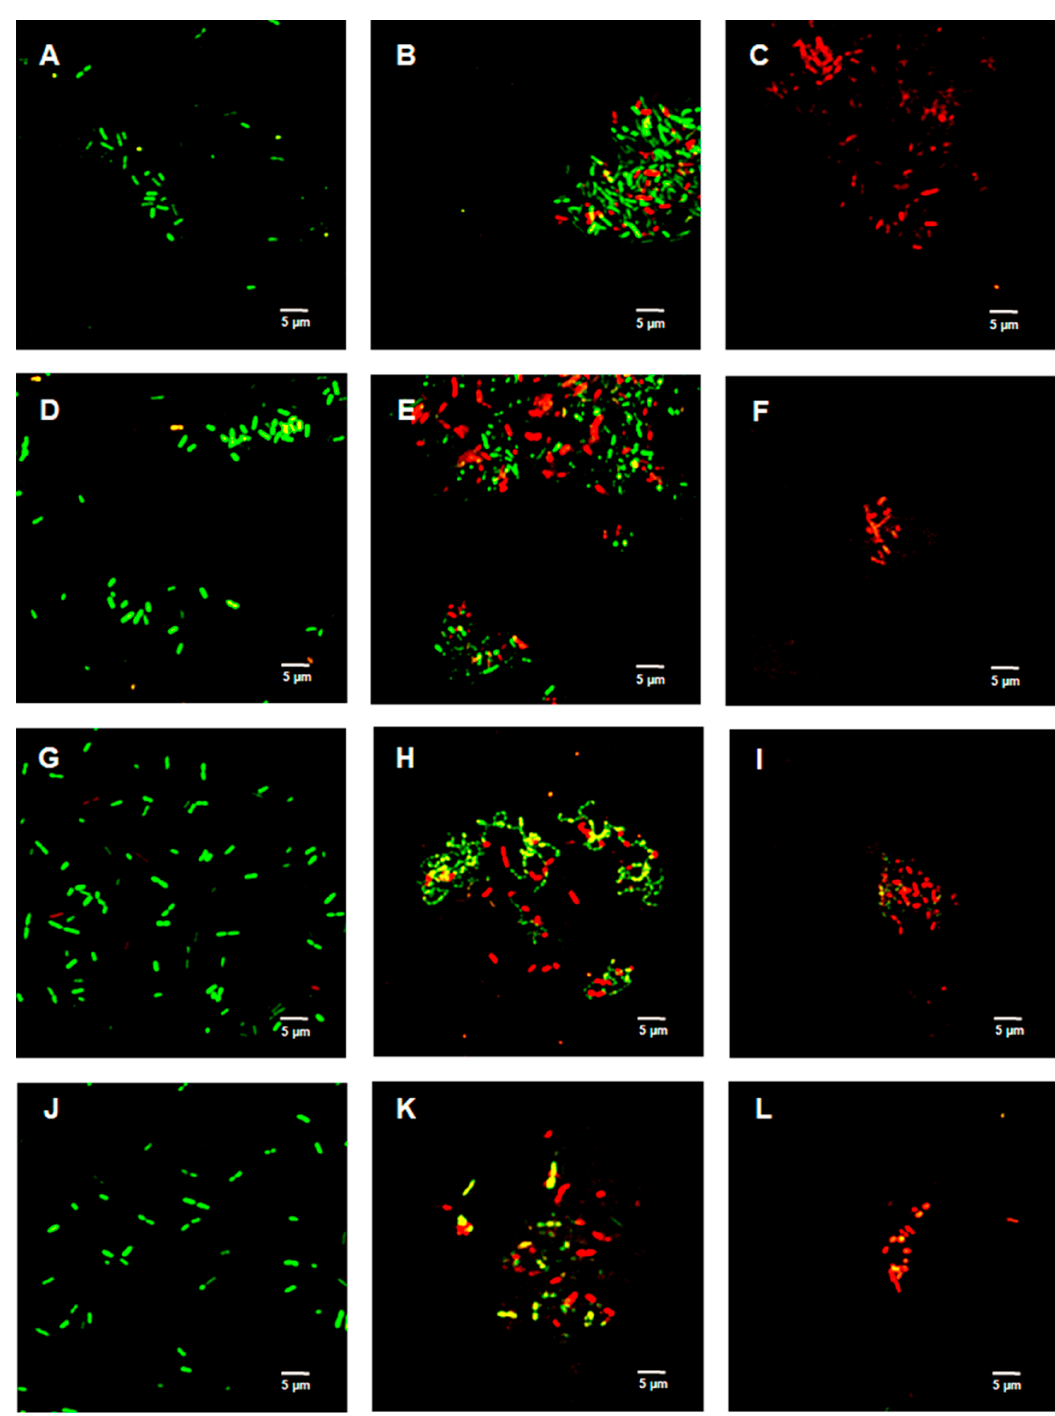
Figure 2. Live/Dead assay of Gram-negative species with various concentrations of TFDG at 6-h incubation. The samples were visualized using Olympus confocal microscope. The green indicates live bacteria, while the red indicates dead bacteria. ( A ) K. aerogenes control; ( B ) K. aerogenes with 62.5 µg/mL TFDG; ( C ) K. aerogenes with 250 µg/mL TFDG; ( D ) E. coli control; ( E ) E. coli with 62.5 µg/mL TFDG; ( F ) E. coli with 250 µg/mL TFDG; ( G ) P. aeruginosa control; ( H ) P. aeruginosa with 62.5 µg/mL TFDG; ( I ) P. aeruginosa with 250 µg/mL TFDG; ( J ) P. mirabilis control; ( K ) P. mirabilis with 62.5 µg/mL TFDG; and ( L ) P. mirabilis with 250 µg/mL TFDG.